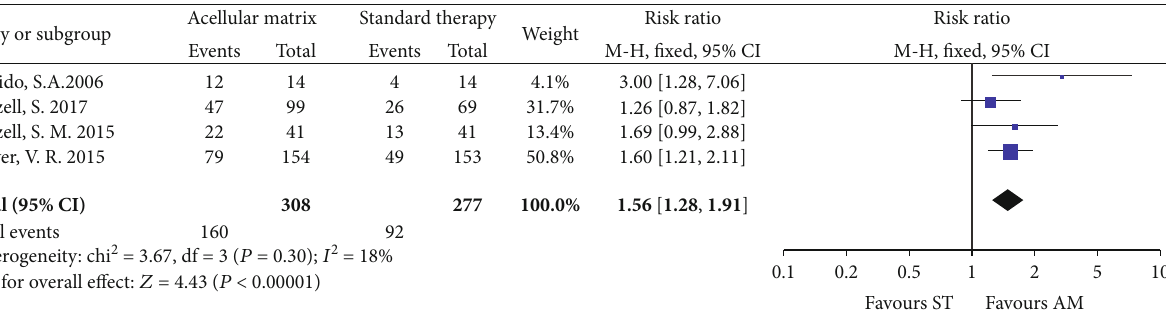
Figure 4: Forest plot of complete healing rate at 16 weeks.